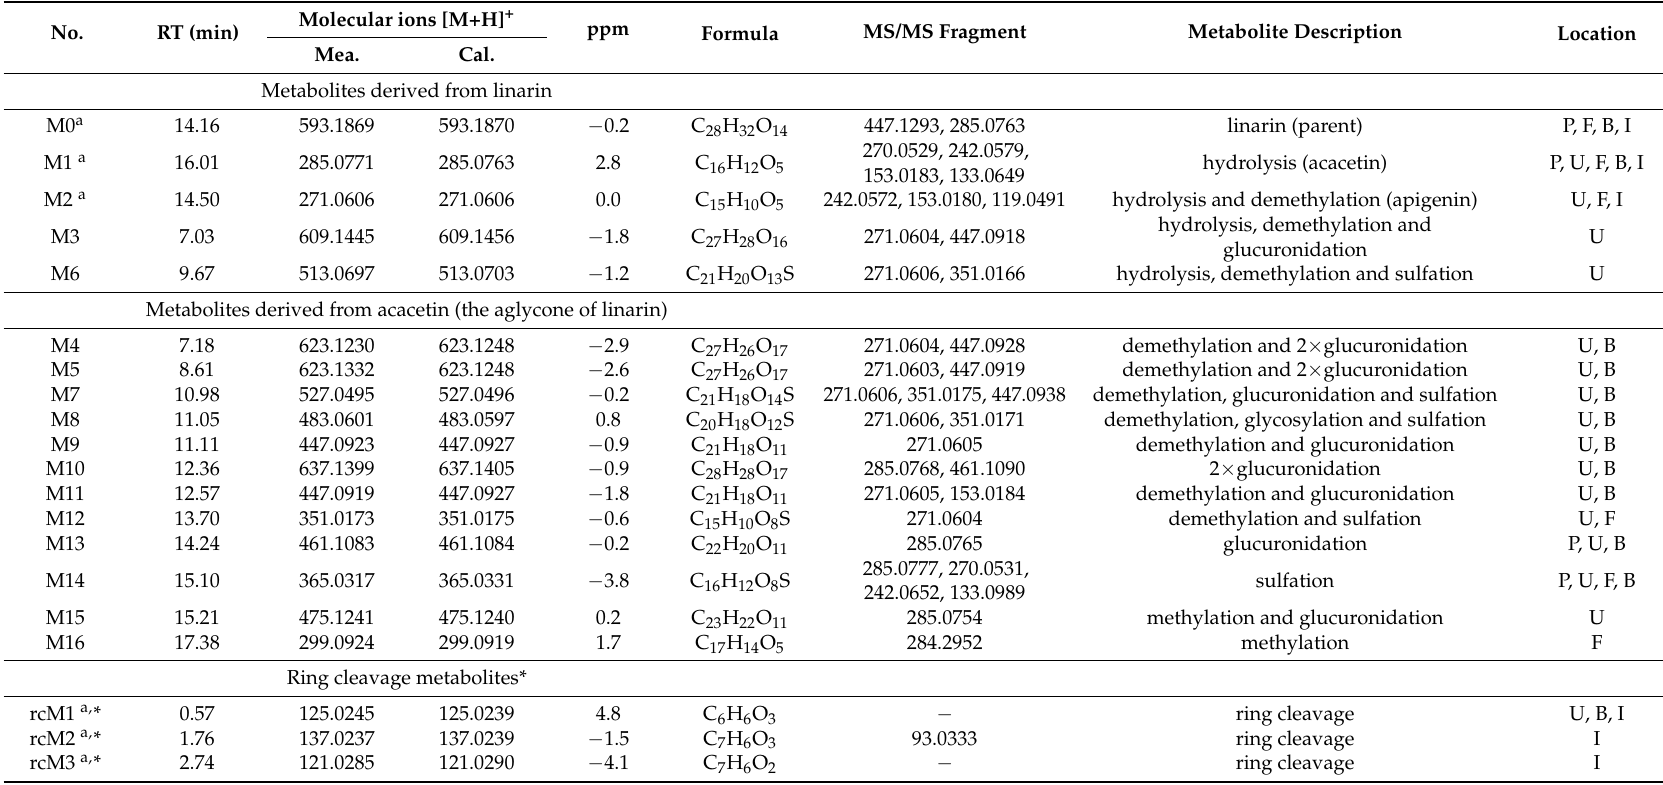
Table 1. Ultra-performance liquid chromatography coupled with quadrupole time-of-flight mass spectrometry (UPLC/Q-TOF-MS/MS) retention times and fragment ions of the metabolites of linarin in rat